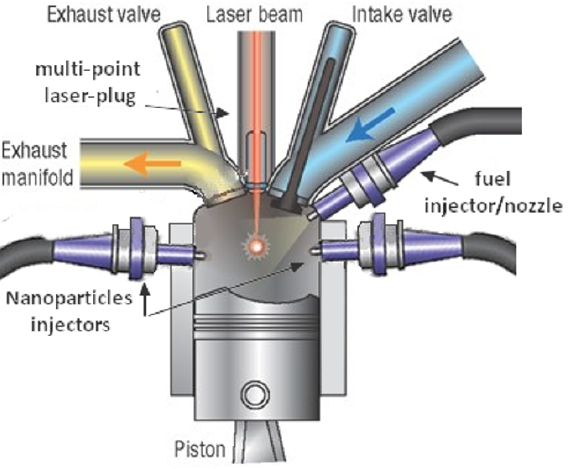
Figure 16: Image of an engine cylinder equipped with the proposed ignition system: the laser plug, with laser beam highlighted, is used to photo-ignite the nano-particles dispersed into the air-fuel mixture through two injectors/nozzles placed on both sides of the engine’s